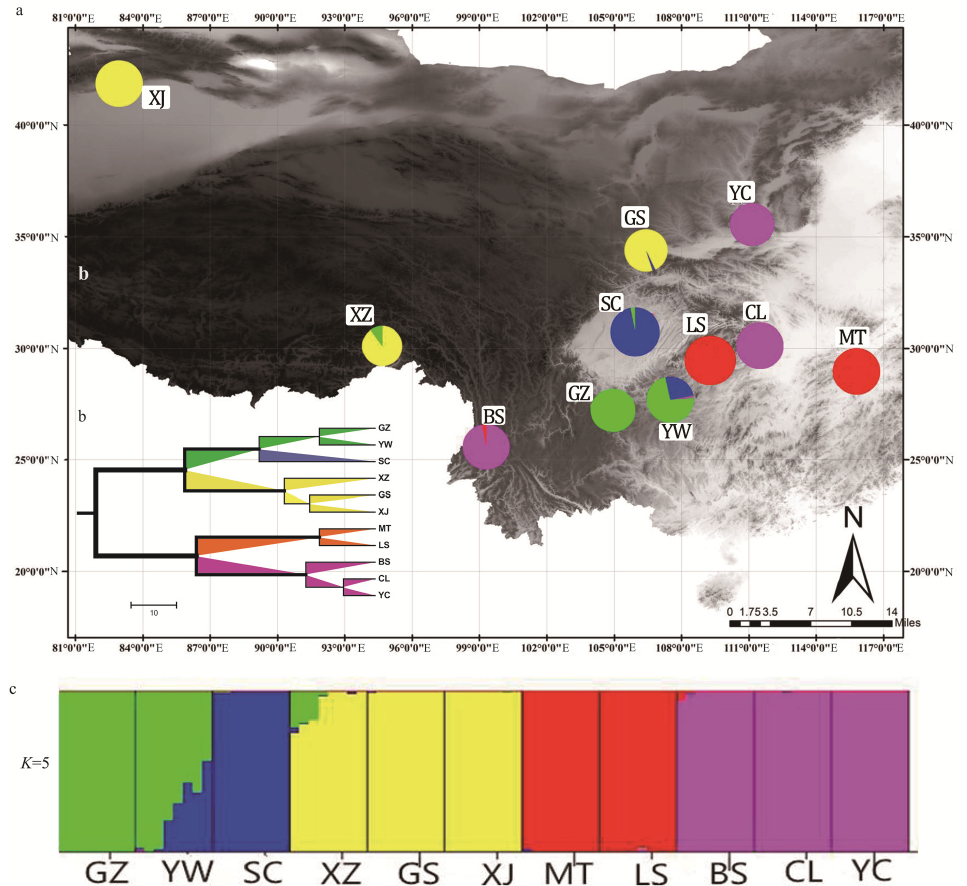
Figure 6. ( a ) Geographical distribution and cluster analysis of 11 J. regia populations using 39 EST-SSR markers in China. Pie charts represent total percentage of each of the five genotypic clusters found among all samples at each sampled site; ( b ) UPGMA cluster analysis of 11 populations of Chinese Persian walnut using 39 SSRs; ( c ) Results of the Bayesian model-based clustering STRUCTURE analysis of 88 individuals of Persian walnut ( K = 5) (Supplemental Figure